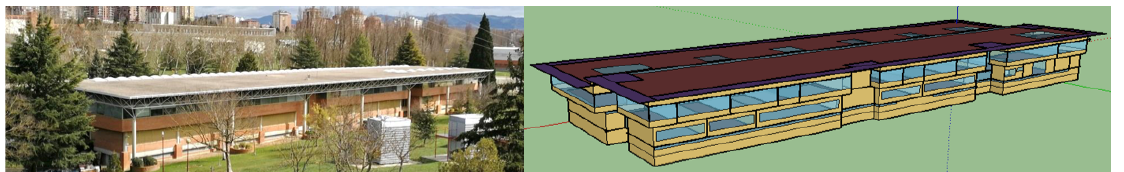
Figure 3. Monthly average temperatures for the different scenarios.